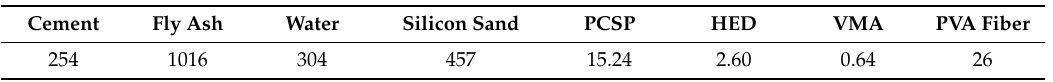
Table 5. Mixture proportions of Polyvinyl alcohol-engineering cementitious composites (PVA-ECCs) (kg / m 3 ).